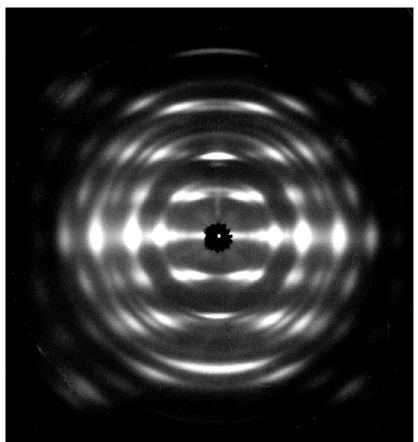
Figure 2. X-ray fiber diffraction pattern of the chitosan–ZnCl 2 complex.